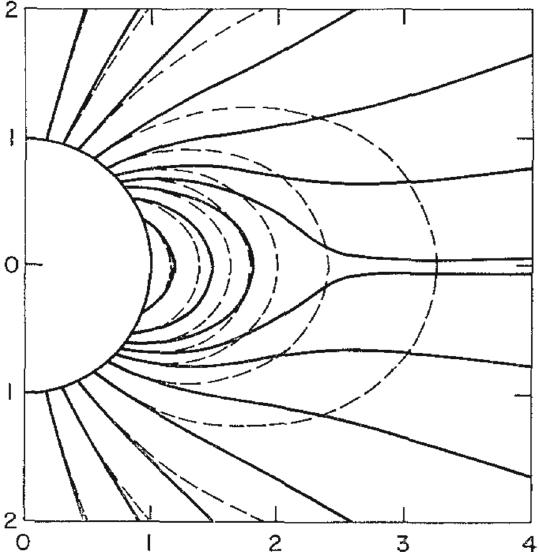
Fig. 11 A comparison of the magnetic field (solid curves) with a potential field (dashed curves) having the same normal component at the reference level. The field lines for the two configurations are chosen so as to be coincident at the